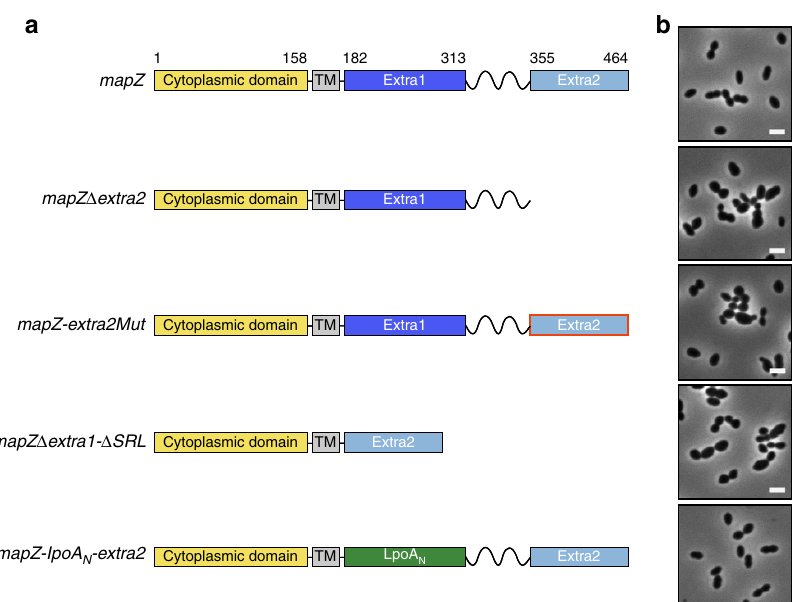
Figure 4 | Schematic organization of MapZ mutants and impact on the cell shape. ( a ) Schematic topological organization of the proteins coded by mapZ mutants. The cytoplasmic domain and the transmembrane domain of MapZ are shown in yellow and dark grey, respectively. The poly-serine linker connecting the two subdomains MapZ extra1 (in dark blue) and MapZ extra2 (in pale blue) is shown as a zig-zag line. The green box represents substitution of MapZ extra1 for the LpoA N domain of E. coli . The red edge around MapZ extra2 symbolizes the seven mutations of conserved amino acids. ( b ) Phase-contrast microscopy images of exponentially growing cells harbouring the wild-type mapZ , mapZ D extra2 , mapZ-extra2Mut , mapZ D extra1- D SRL and mapZ-lpoA N - extra2 genes at 37 (cid:2) C in Todd Hewitt Yeast medium. Scale bar, 2 m m.